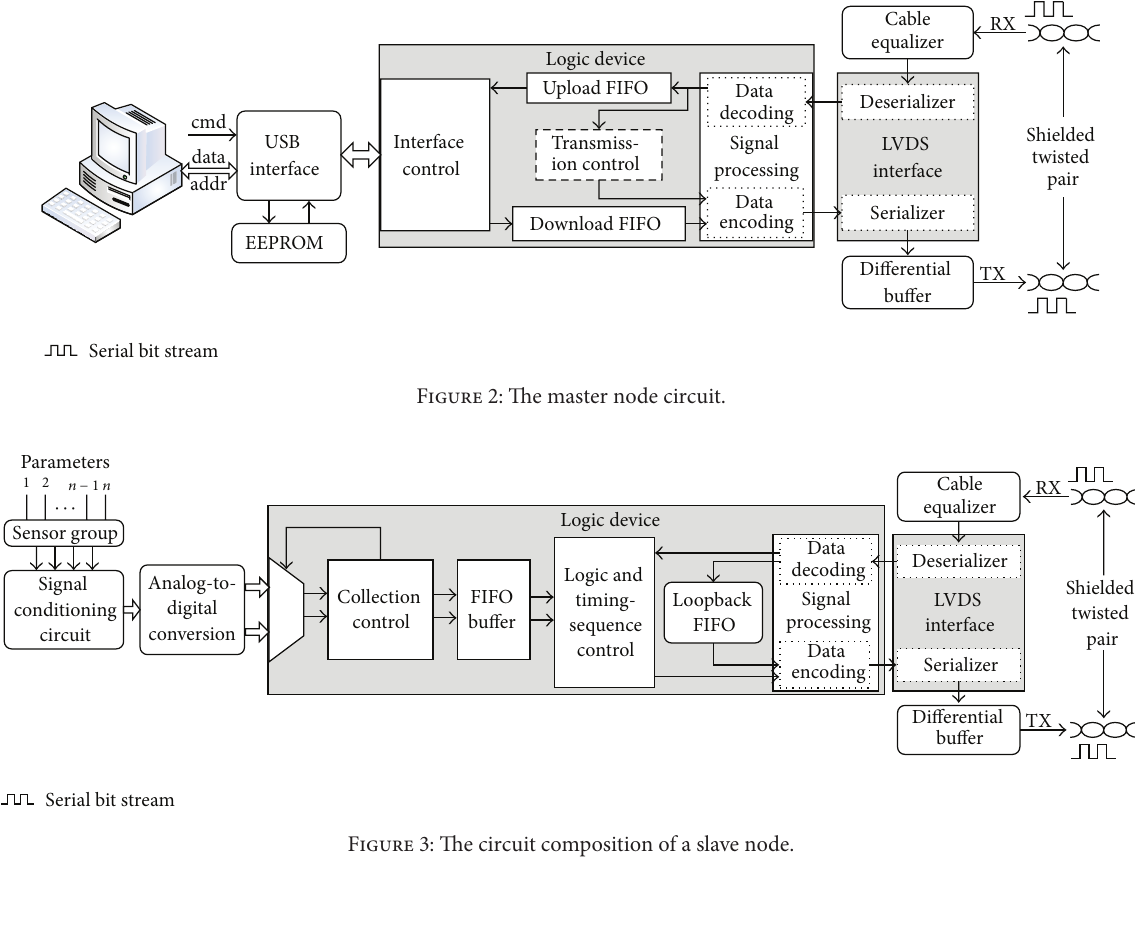
Table 1: Transmission protocol